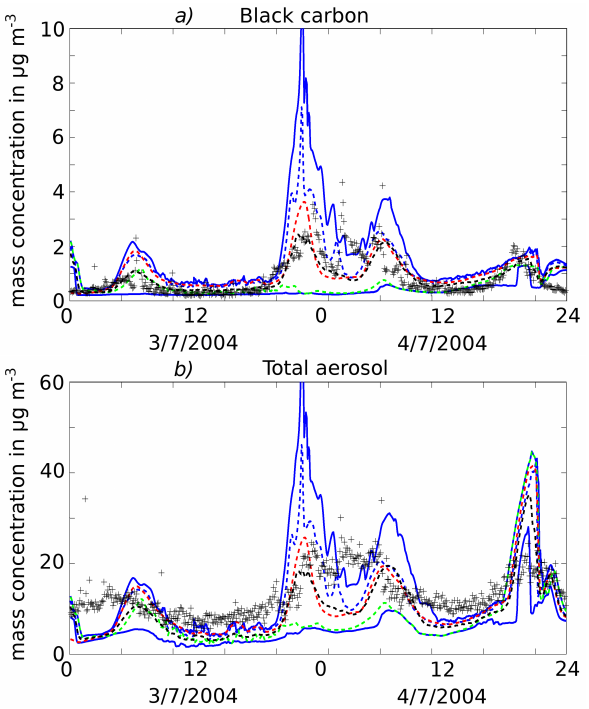
Fig. 6. (a) Black carbon and (b) total aerosol mass concentration in µgm − 3 measured (black crosses) and modeled at the downtown- site in dashed blue, red and green line standing for the results from the 3rd, 2d and 1st domain respectively. The minimum and max- imum modeled values located at the position of the 21 downtown dynamical stations are drawn for the 3rd domain in continuous blue line. The corresponding average value is drawn in dashed black line.